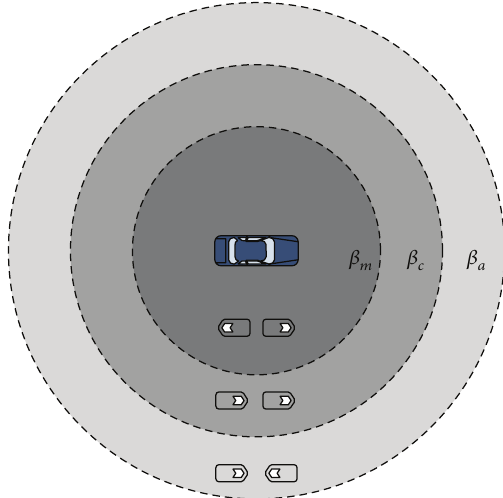
Figure 2: Use of dynamic 𝛽 𝑚 , 𝛽 𝑐 , and 𝛽 𝑎 factors to determine the maximum allowed transmission range according to the relative direction of vehicles.